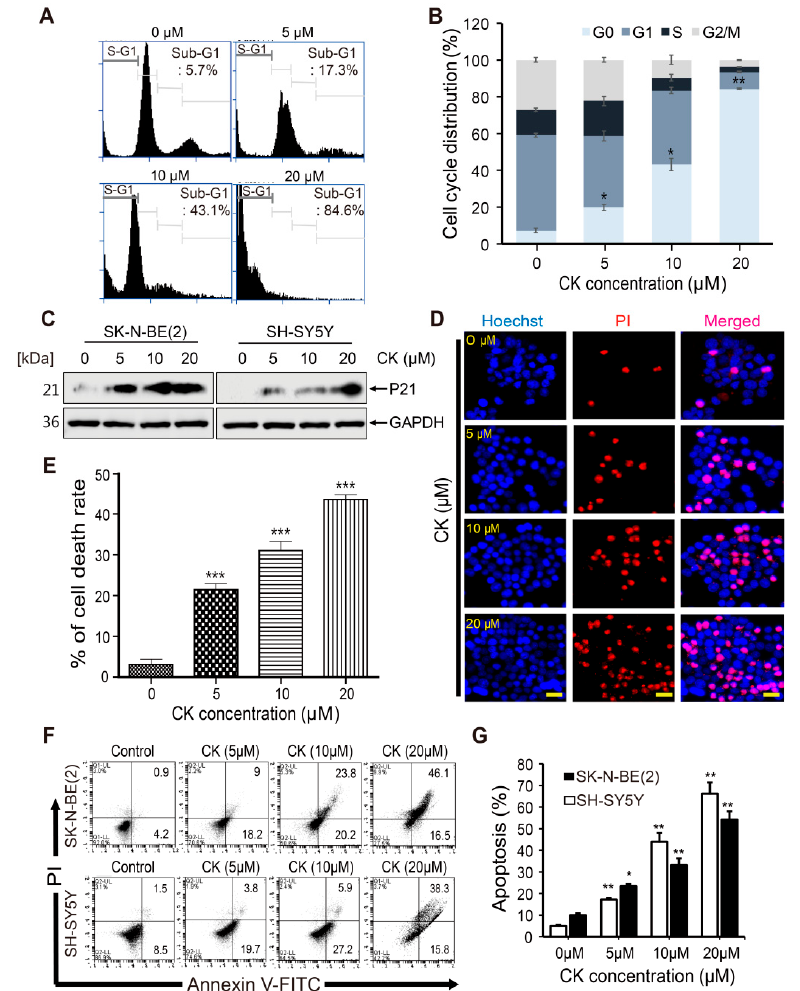
Figure 2. CK induced cell cycle arrest and apoptotic cell death in neuroblastoma cells. ( A ) Cell cycle distribution of SK-N-BE(2) cells treated with 0, 5, 10, and 20 µ M CK for 24 h was detected and analyzed by flow cytometry following staining with PI. Quantitative analysis of cells in each cell cycle phase was performed. ( B ) Representative images of flow cytometry are shown. The experiment was repeated in triplicate. Data represent mean ± SD. *: p < 0.05 or **: p < 0.01 versus control. ( C ) The expression of P21 protein levels was examined by western blot after CK treatment for 24 h in neuroblastoma cells. ( D ) Nuclear structures of SK-N-BE(2) cells were analyzed via fluorescence microscope. The cells were fixed and stained with Hoechst 33342 / PI solution for 10 min at room temperature. ( E ) The ratio of PI staining (red) and Hoechst 33342 staining (blue) represented cell death rates. Data are presented as the mean ± SD of three independent experiments. ***: p < 0.001 versus control. Scale bar: 50 µ m. ( F ) Apoptotic cell death was determined by Annexin V / PI flow cytometry analysis. SK-N-BE(2) and SH-SY5Y cells were treated with di ff erent concentrations of CK (0, 5, 10, 20 µ M) for 24 h. The results shown are representative of three independent cytometric analyses. Histograms illustrate the number of cells undergoing apoptosis. ( G ) The percentage of apoptotic cells is shown. Data are mean ± SD of three independent experiments. *: p < 0.05, **: p < 0.01 versus control